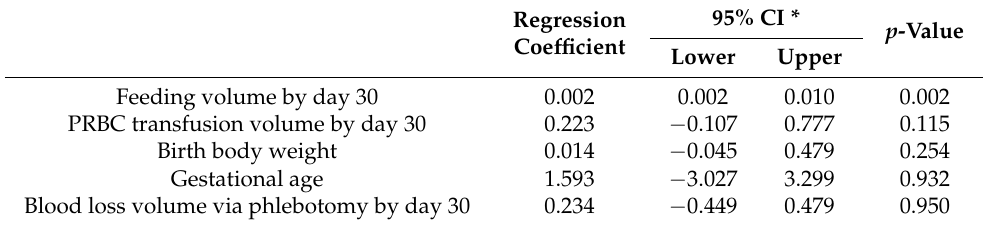
Table 4. Multiple regression analysis of factors for serum iron levels.